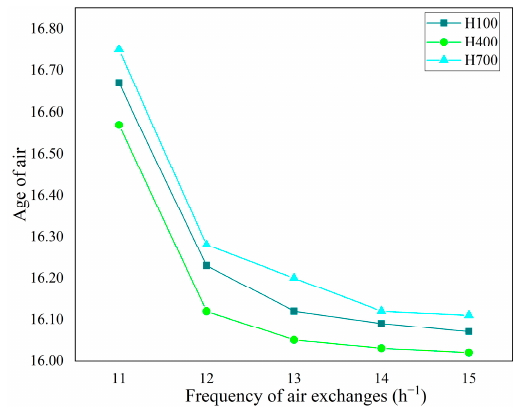
Figure 14. Age of air. Figure 14. Age of